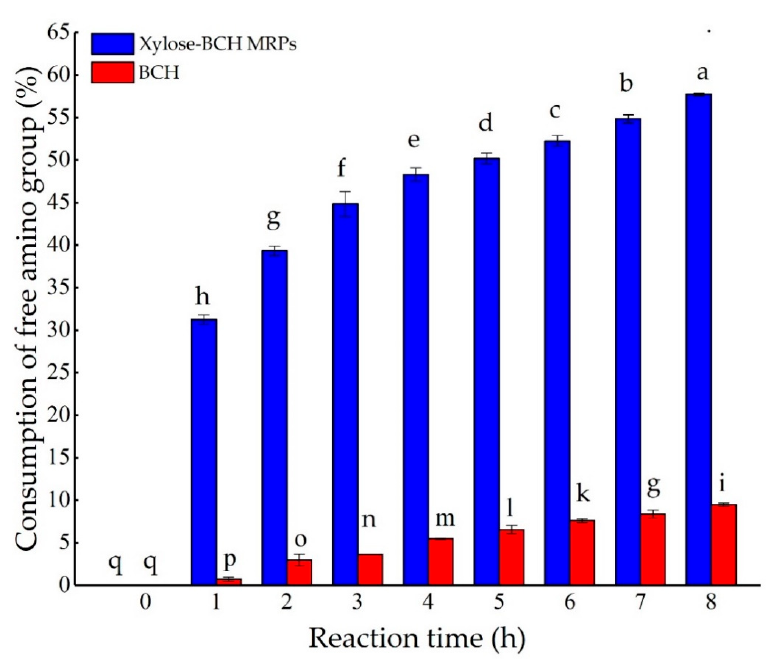
Figure A4. Effect of reaction time on the loss of free amino groups content of xylose–BCH MRPs and BCH. The standard deviation is showed by error bars. Data points with diverse letters are significantly different ( p < 0.05).